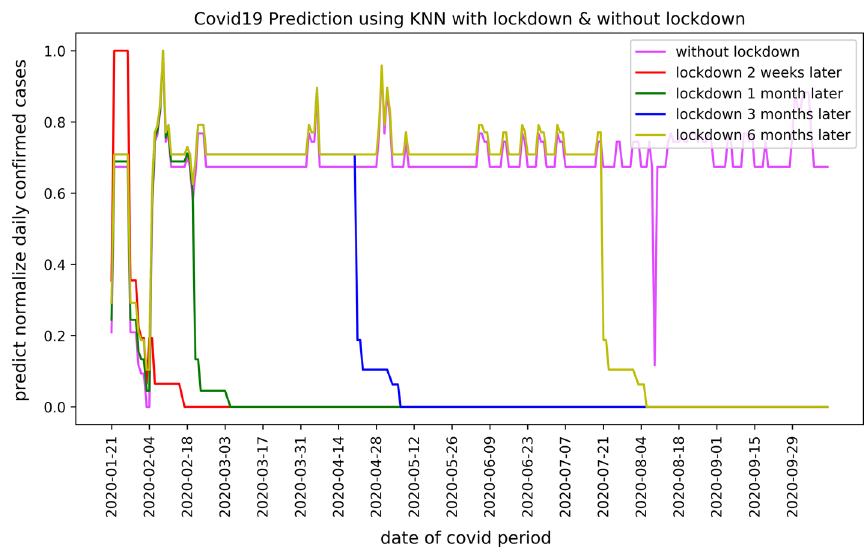
Fig. 7 Predicted COVID-19 confirmed cases using